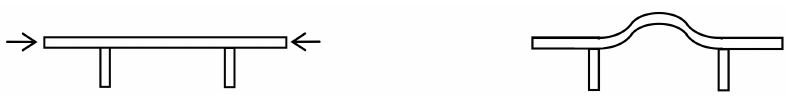
Figure 1. Deformation of continuous micromirrors induced by compressive